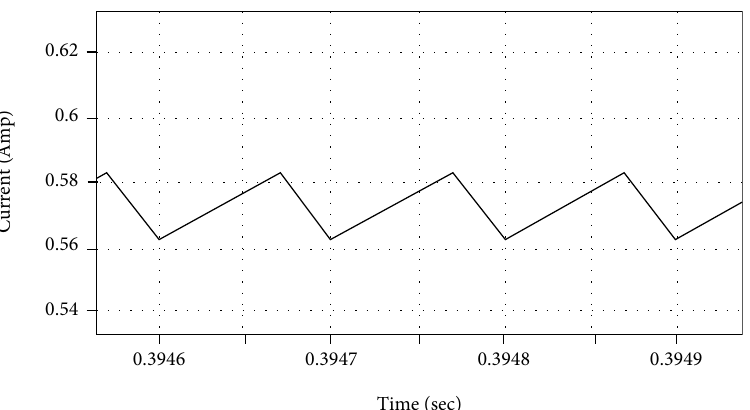
Figure 10: Phase current across L